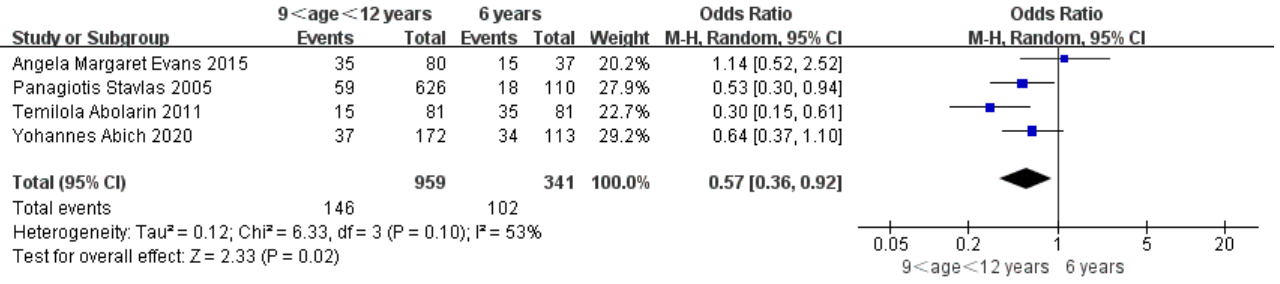
Figure 8. The forest plot of exercise time for flatfoot in children [9,16,20].